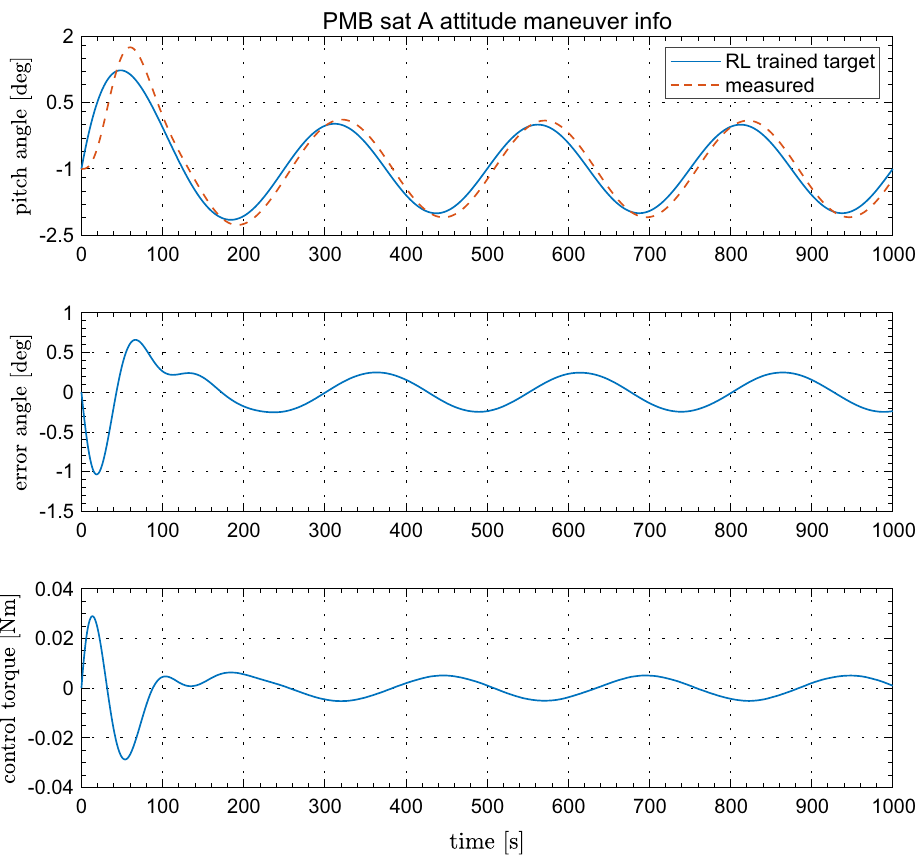
Figure 10. Satellite A pitch maneuver attitude information during software APC calibra- tion simulation.